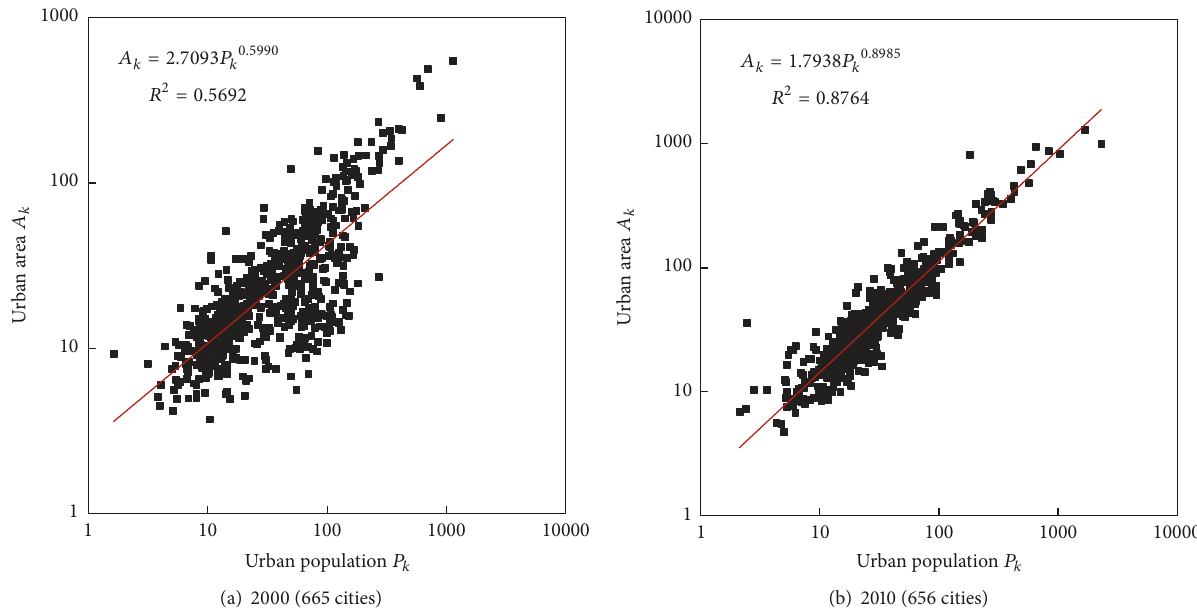
Figure 3: The allometric scaling relationships between urban population and urbanized area based on the rank-size distributions of Chinese cities [ Note. Due to the fact that some satellite towns were incorporated into vicinal large cities, the total number of officially approved cities fell from 2000 to 2010. In 2000, Chinese cities failed to follow the allometric scaling